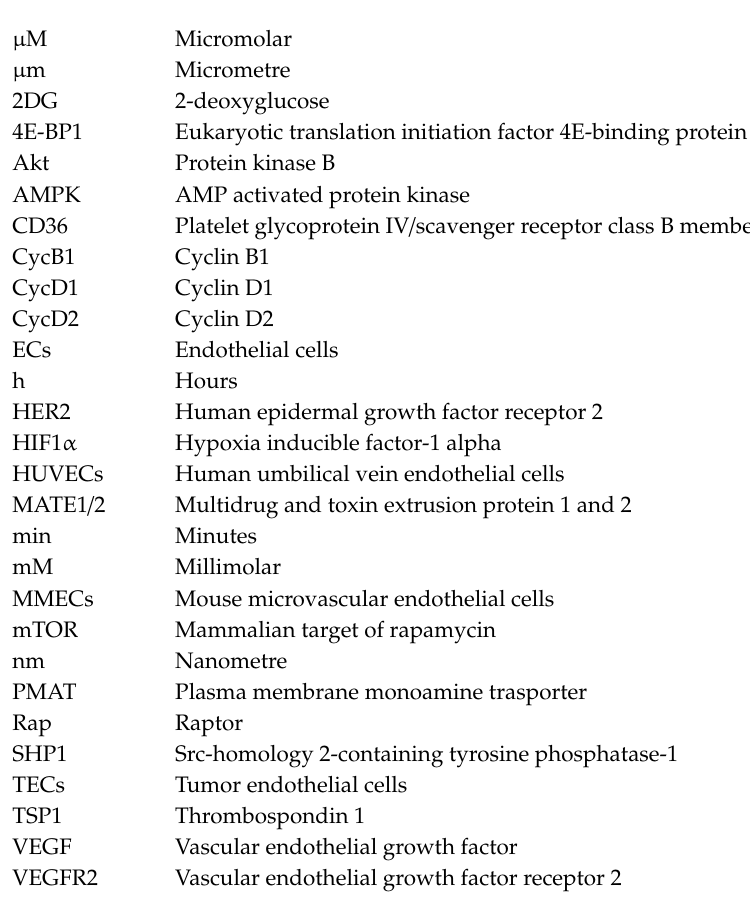
blot, ECL images and image overlays indicating β -tubulin and β -actin for representative Western blots used in Figure 10A of the manuscript, Figure S24. Original unedited blot, ECL images and image overlays indicating OCT2 and OCT3 for representative Western blots used in Figure 10A of the